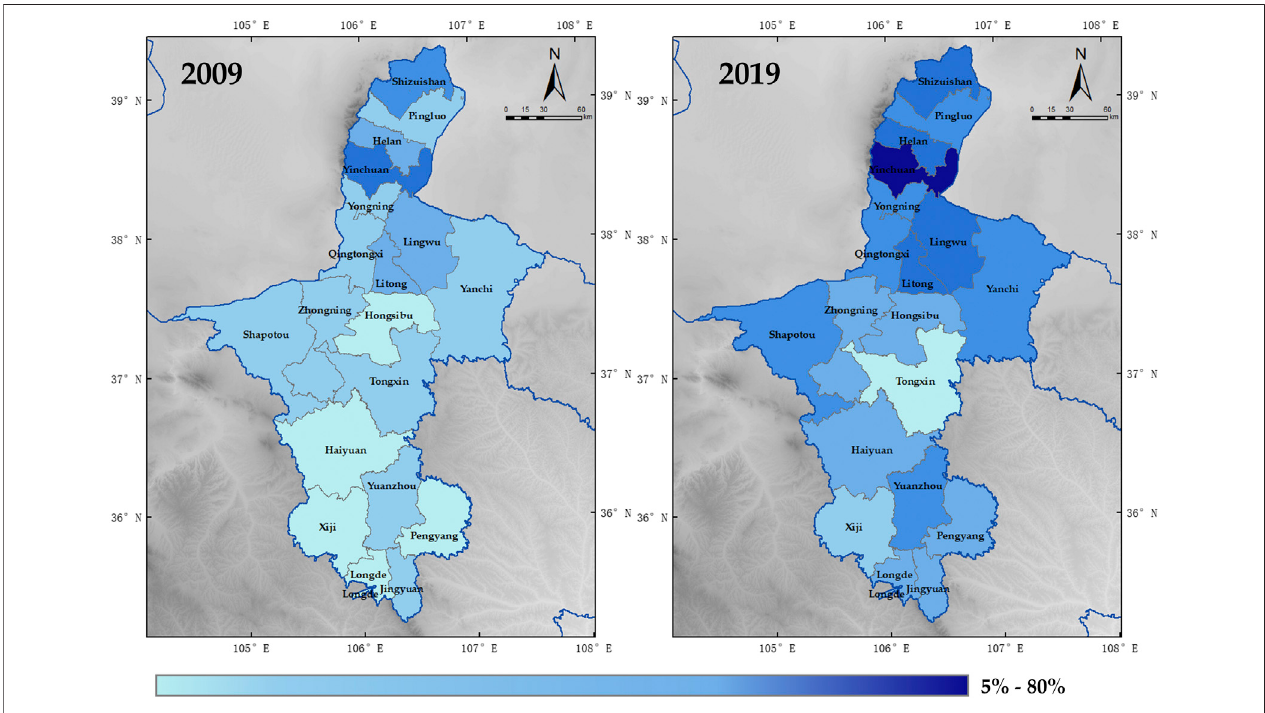
FIGURE 5 | Evaluation of urbanization of various regions in Ningxia from 2009 to